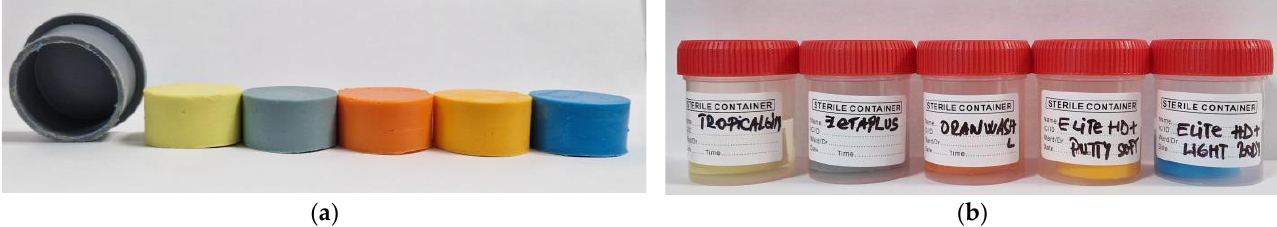
Figure 2. Preparation of the specimens: ( a ) the plastic plug and one specimen from each impression material; ( b ) the containers with the microorganisms and the specimens.